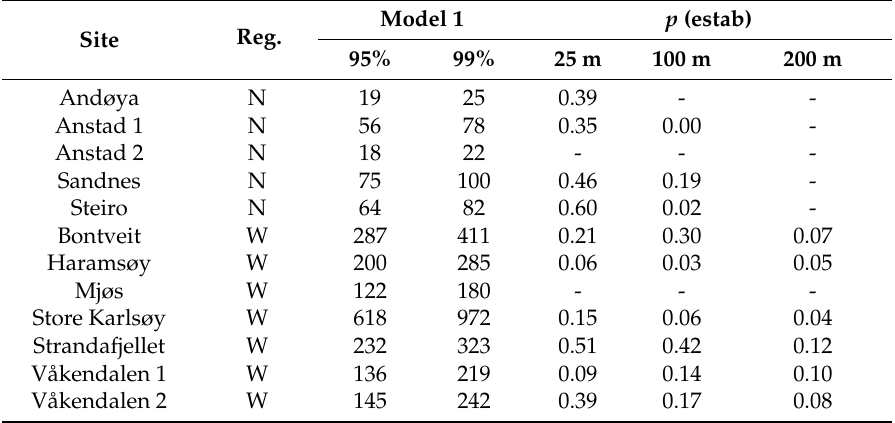
Table 5. Distance from edge including 95% and 99% of the expected established saplings given by Model 1. p (estab) denotes the probability for one successful establishment per 10 × 10 m square estimated by Model 1 in distances 25, 100, and 200 m from the